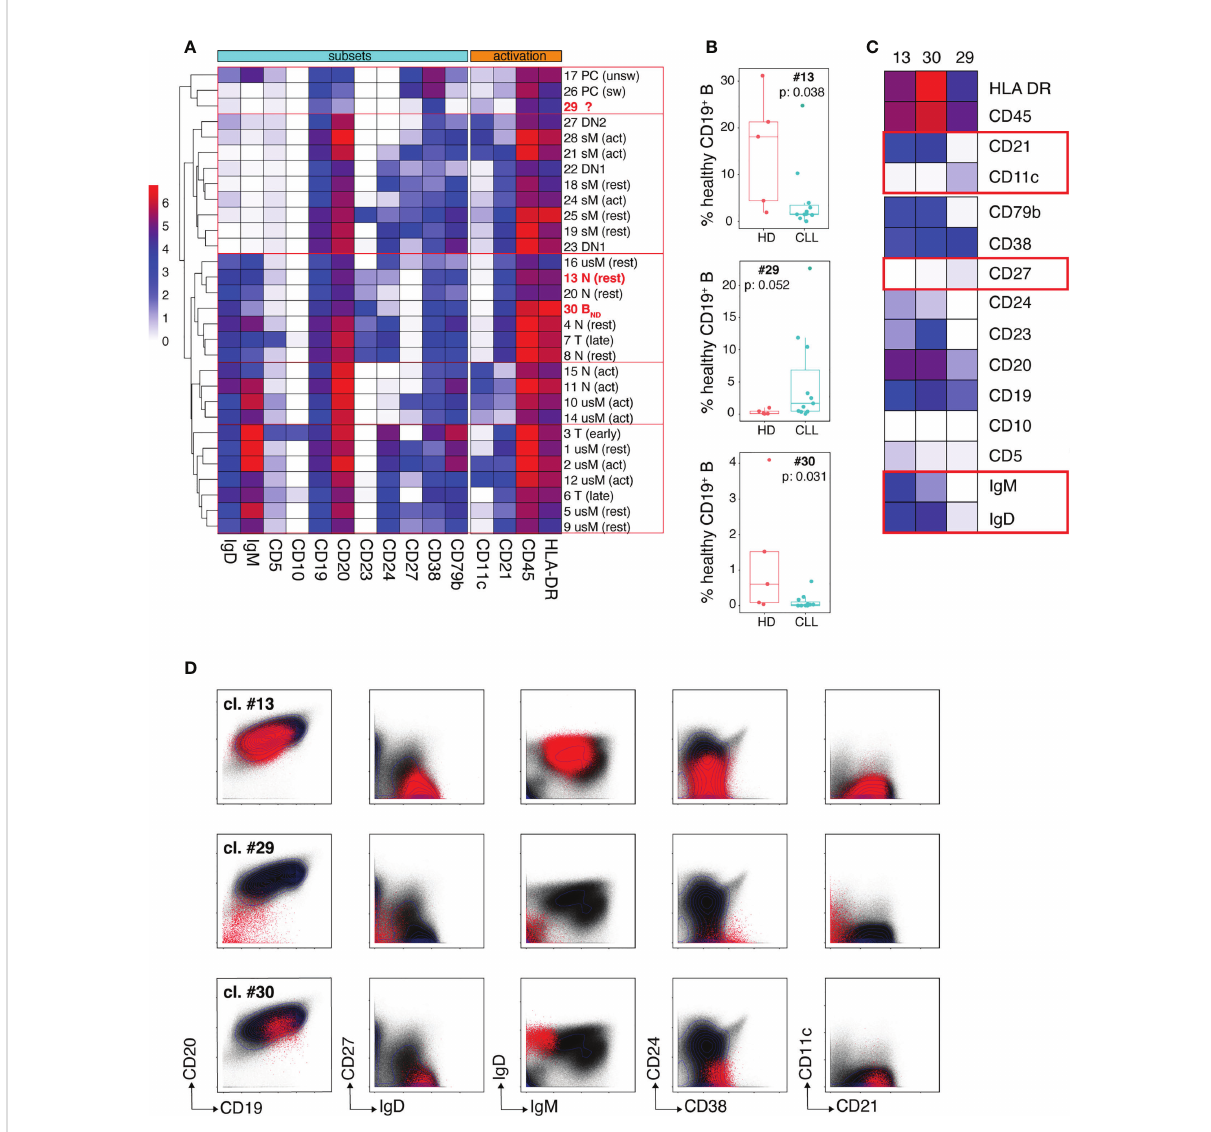
FIGURE 3 Dissection of the non-malignant peripheral B cell compartment of CLL patients. (A) Heatmap showing median intensity of the indicated markers for the 30 healthy B cell clusters individualized by the FlowSOM algorithm and their clustering results as performed by the hclust software. The phenotypical criteria used for manual annotation of the clusters are described in the results section. T: transitional B cells, N: naïve B cells, usM, sM, DN1 and DN2 stand for unswitched conventional mBCs, switched conventional mBCs and double negative mBCs type 1 and 2, respectively. PCs: plasma cells. The 3 clusters which frequency modulation in CLL patients was statistically signi fi cant are identi fi ed in bold red. (B) Box and whisker plots of the frequencies of cells (expressed in % of the whole healthy B cell population) for the three clusters (13, 29 and 30) that showed disease-associated modulation. (C) Heatmap showing median intensity of the indicated markers for clusters 13, 29 and 30. The red boxes identify markers which are determinant for cluster-to-B cell subtype assignment. (D) Biaxial plots showing expression of the indicated markers by cells from clusters 13, 29 and 30 visualized as red dots overlayed onto the expression pro fi le of the markers on the entire healthy B cell population (black dots). In (B) box and whisker plots are shown with the median, interquartile range (IQR, a box with lower and upper bonds representing 25th and 75th percentiles, respectively) and 1.5 times the IQR